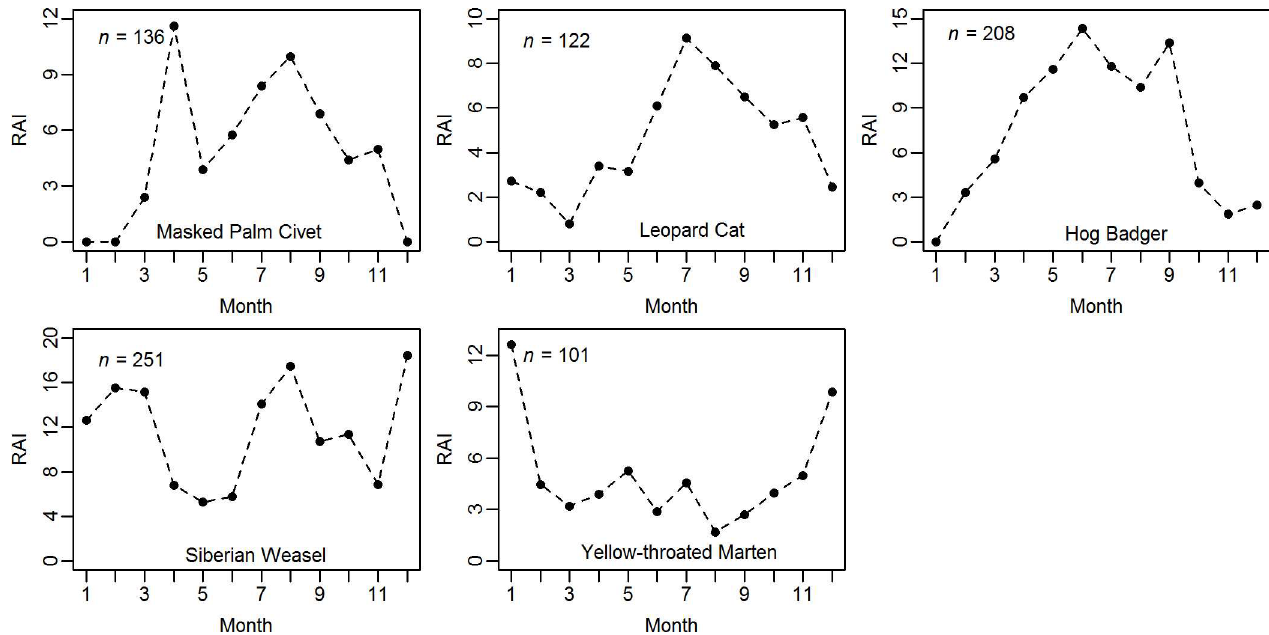
Fig 2. Relative activity indices (RAI, number of detections per 1,000 camera-days) in each month and number of total detections ( n ) for each mesocarnivores in Minshan Mountains, Southwest